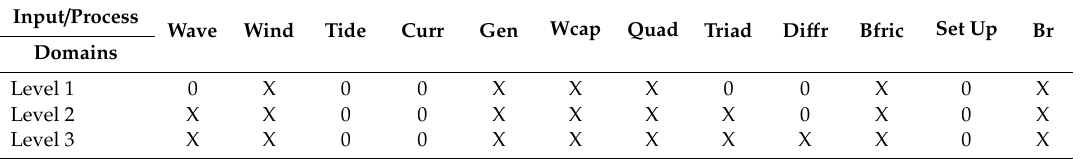
Table 2. Physical processes activated in the SWAN simulations corresponding to the three computational domains defined. (X—process activated, 0—process